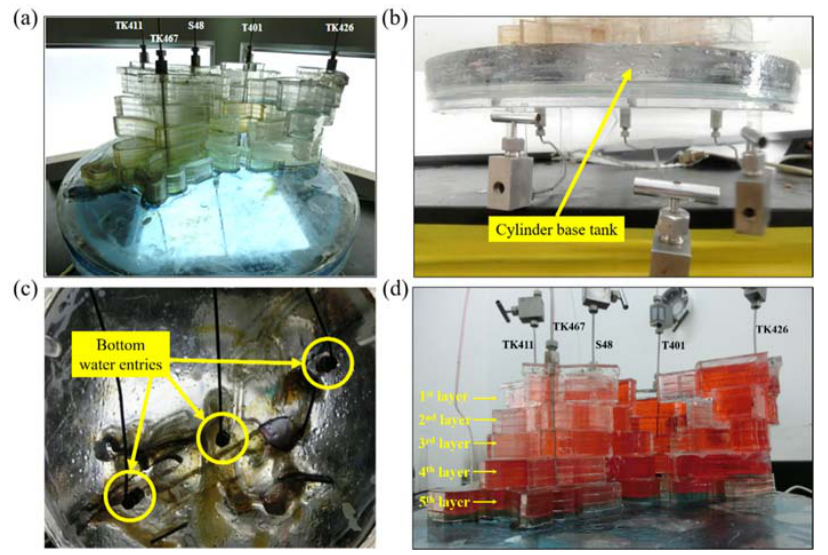
Figure 2. Three-dimensional visualized fracture–vuggy physical model: ( a ) initial state, ( b ) cylinder base tank, ( c ) bottom water entries, ( d ) saturated simulated oil